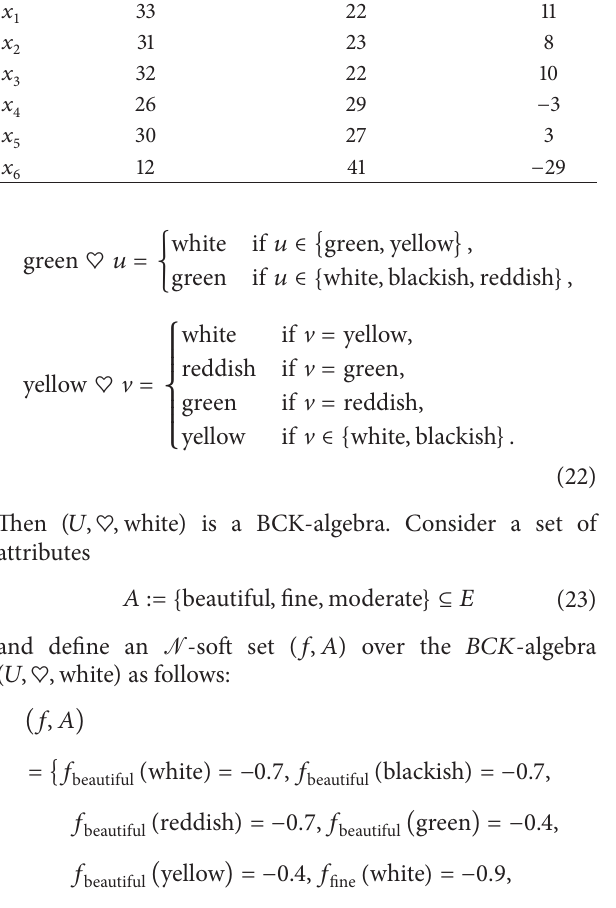
Table 3: Raw-sum, column-sum, and the score. Row-sum ( 𝑟 𝑖 )